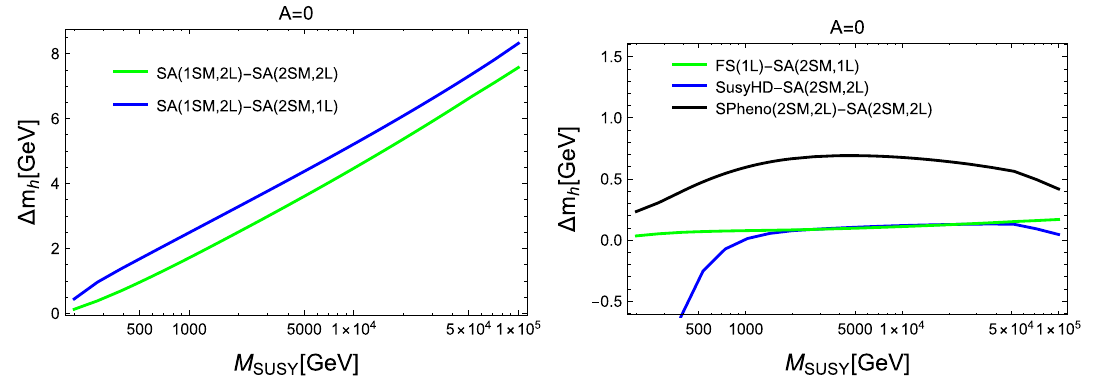
Fig. 9 On the left : difference between the Higgs mass as predicted by the new SARAH and the old version using one- ( blue ) or two-loop ( green ) matching conditions for λ SM at the SUSY scale. On the right : the differences between SARAH and the new stand-alone SPheno ver-